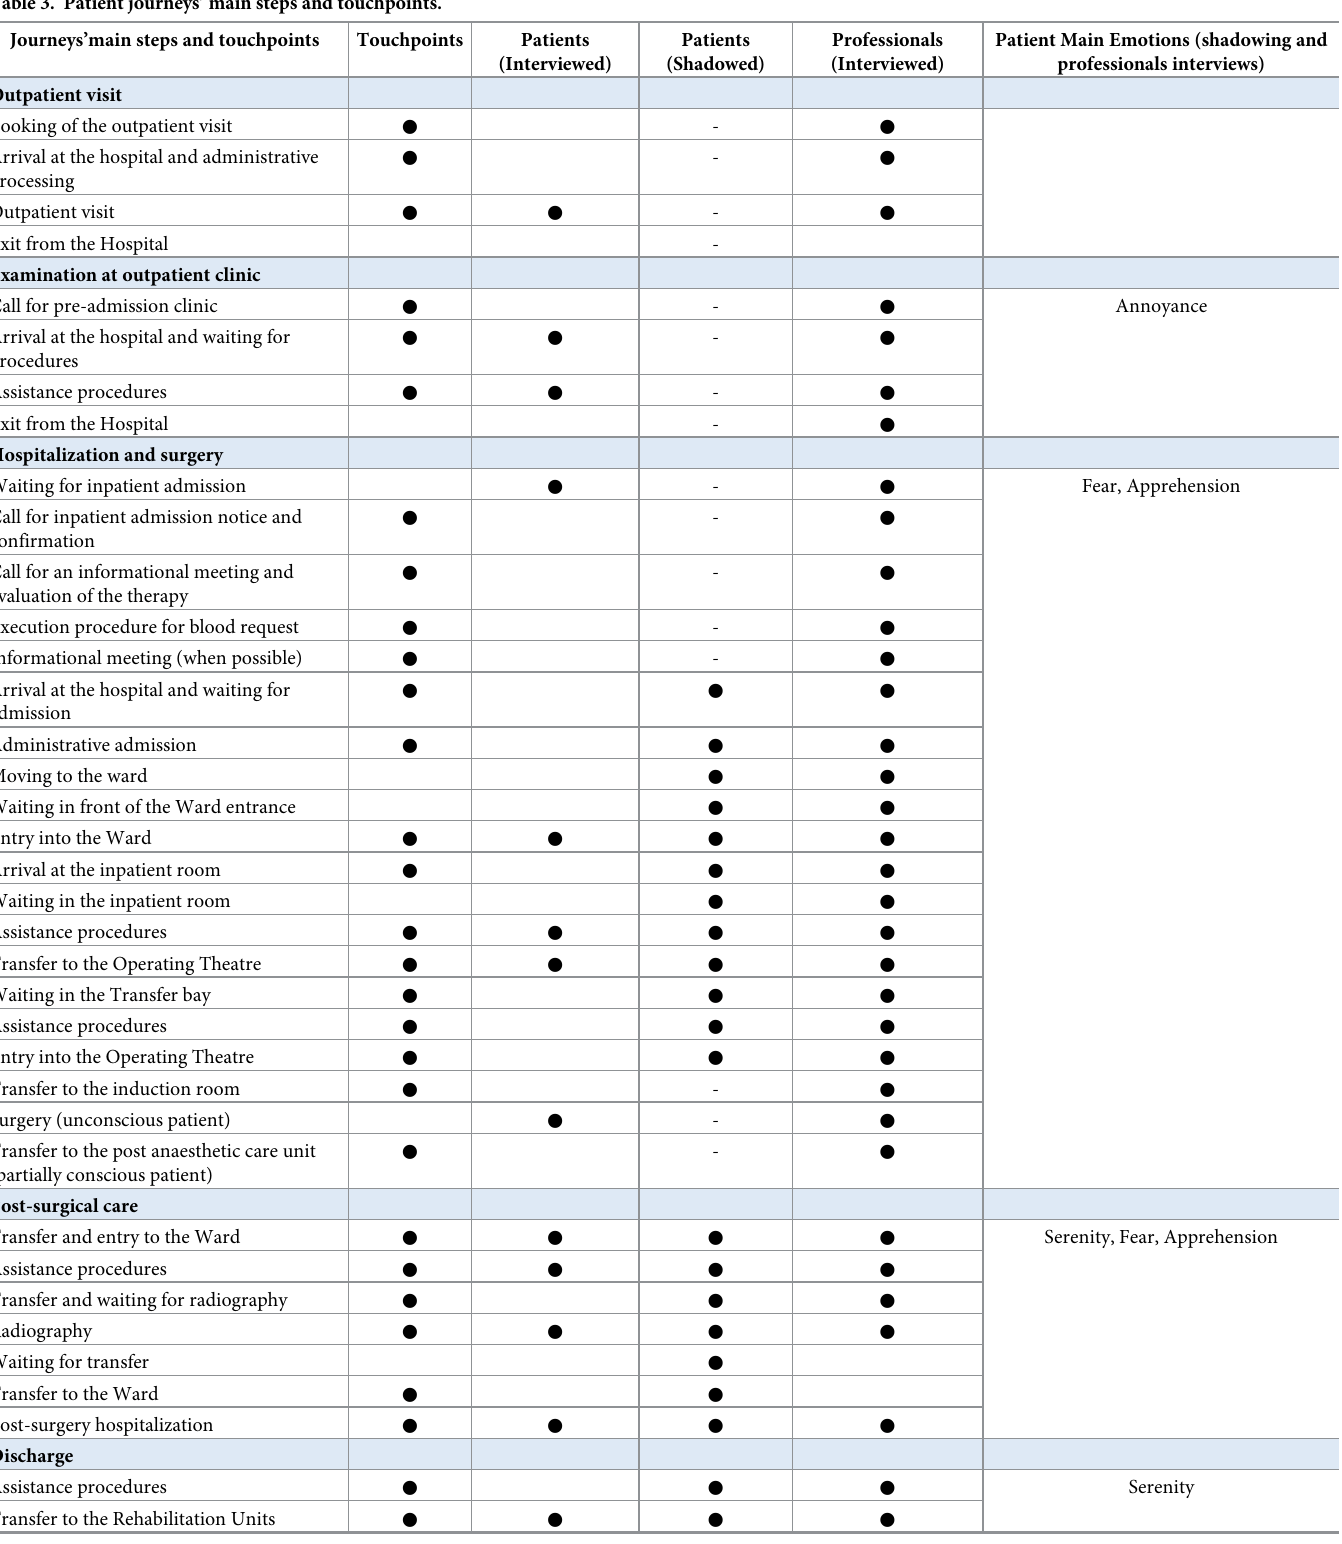
Table 3. Patient journeys’ main steps and